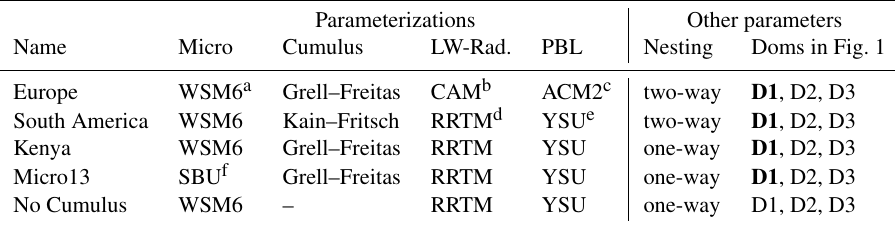
Table 1. The setups of each simulation are described with: name of the experiment, parameterizations used and other parameters, such as nesting option and the number of domains. Bold domains indicate that the cumulus parameterization is turned on.